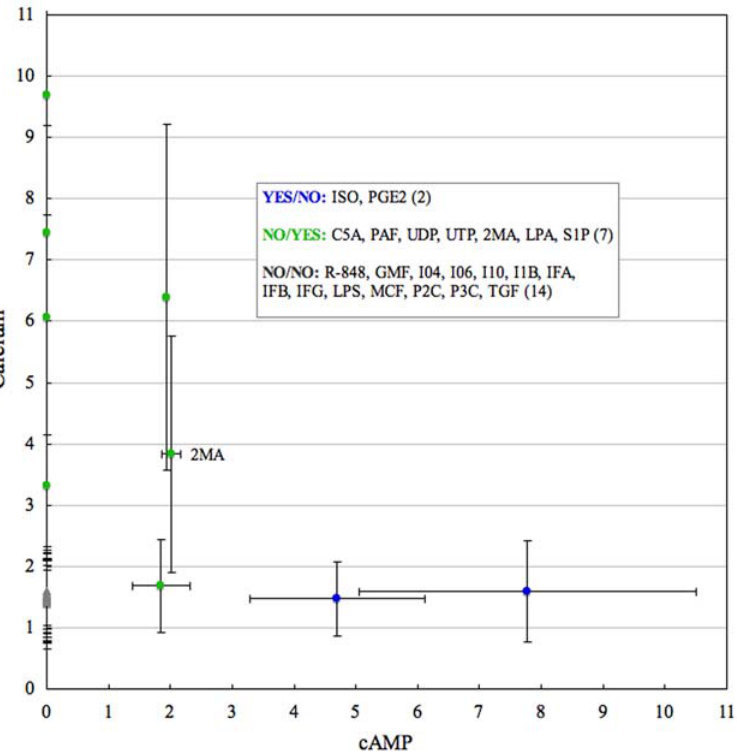
Figure 3. Peaks of fold changes for 23 macrophage ligands classified into three groups with observed ‘YES’ and non-observed ‘NO’ elevation of Ca 2 + and cAMP. Standard deviations (SD) are shown by the vertical bars. Full names for the ligands are listed in Figure S2. Values equal to zero for cAMP correspond to the experimentally uncharacterized cAMP. 2MA ligand is marked to be visible as it is given more detailed discussion in the manuscript.